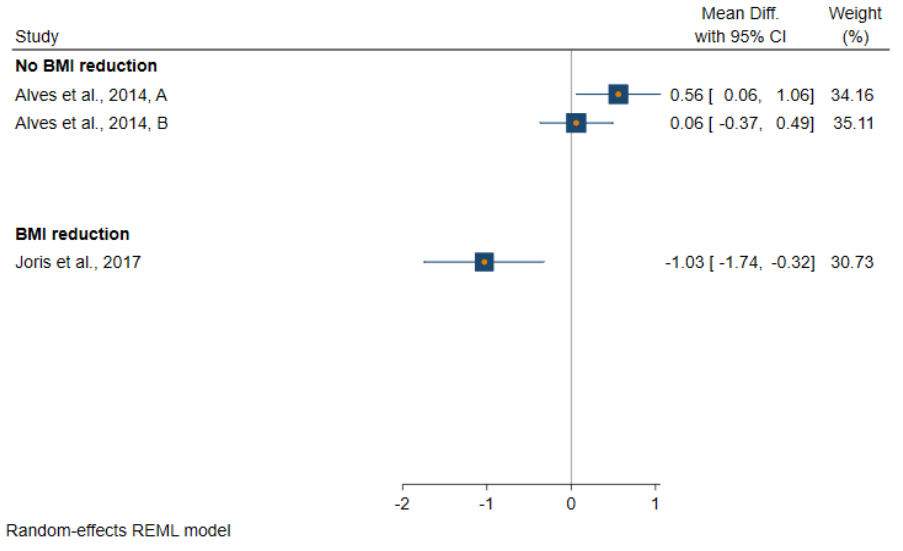
Figure 5. Forest plot of studies which evaluated an effect of a reduction in body fatness on HOMA-IR